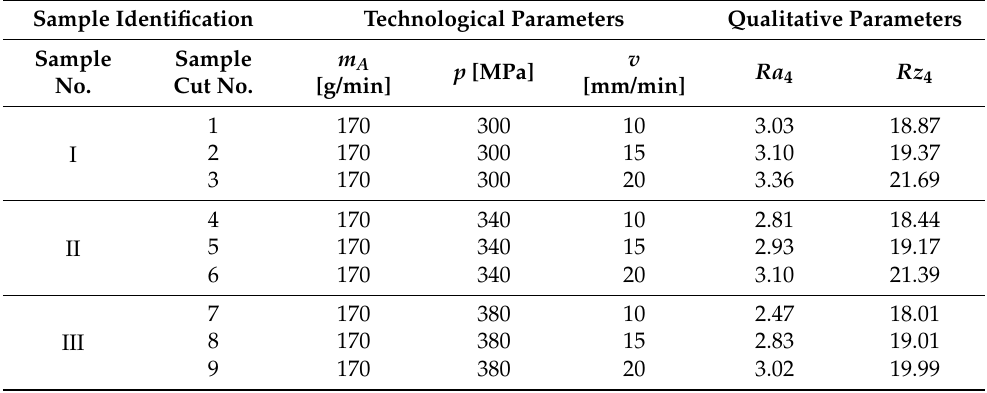
Table 2. Values of the roughness parameters Ra 4 and Rz 4 as measured on the cut surfaces of the samples at a distance of 4